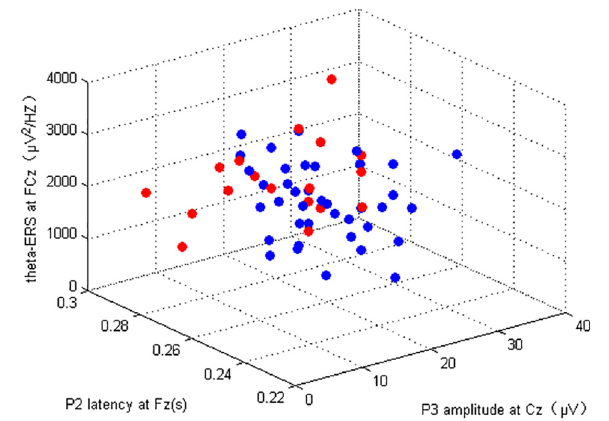
FIGURE 6 | High ability (blue) and LA (red) individual location determined by three EEG indicators.